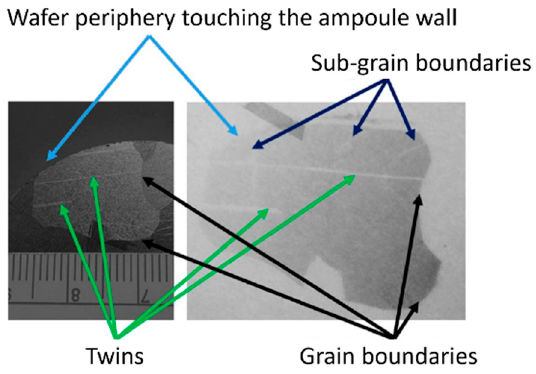
Figure 1. Optical photograph of grain boundaries observed in a typical THM grown CZTS crystal (left) and the corresponding X-ray topographic image (Adapted from Roy et al. Sci. Rep. 2019 , 9 , 1620. Copyright 2019 Nature Research under Creative Commons Attribution 4.0 International Li- cense.]).